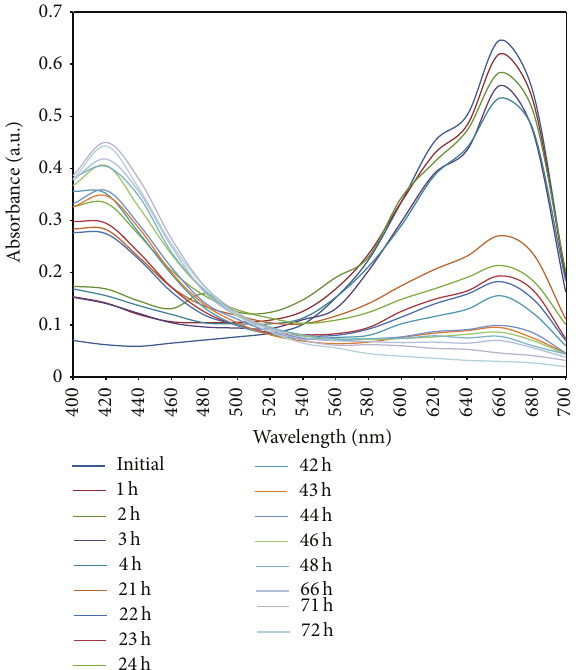
Figure 9: The absorption spectra of aqueous solution of methylene blue treated with 10mg of synthesized silver nanoparticles using M. tinctoria at different time intervals.